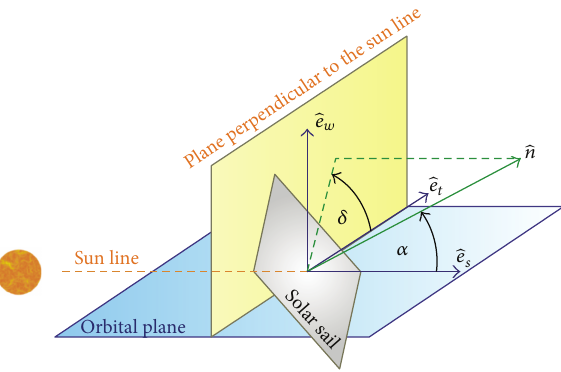
Figure 2: Definition of sail control